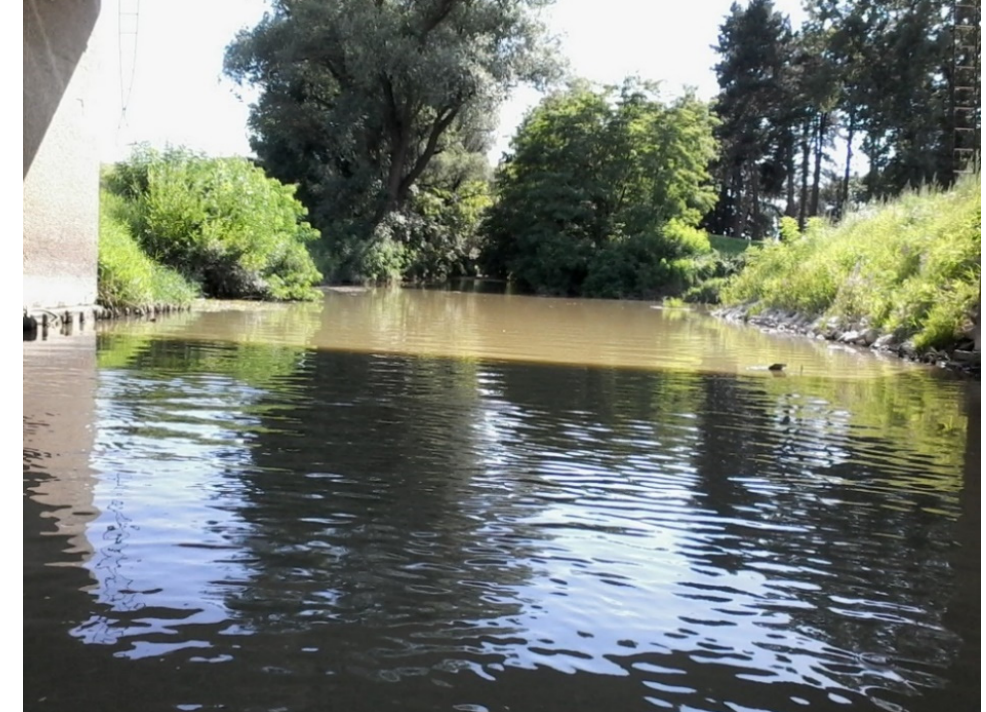
Figure 8. View at the measuring station of Ludbreg on the river Bednja.